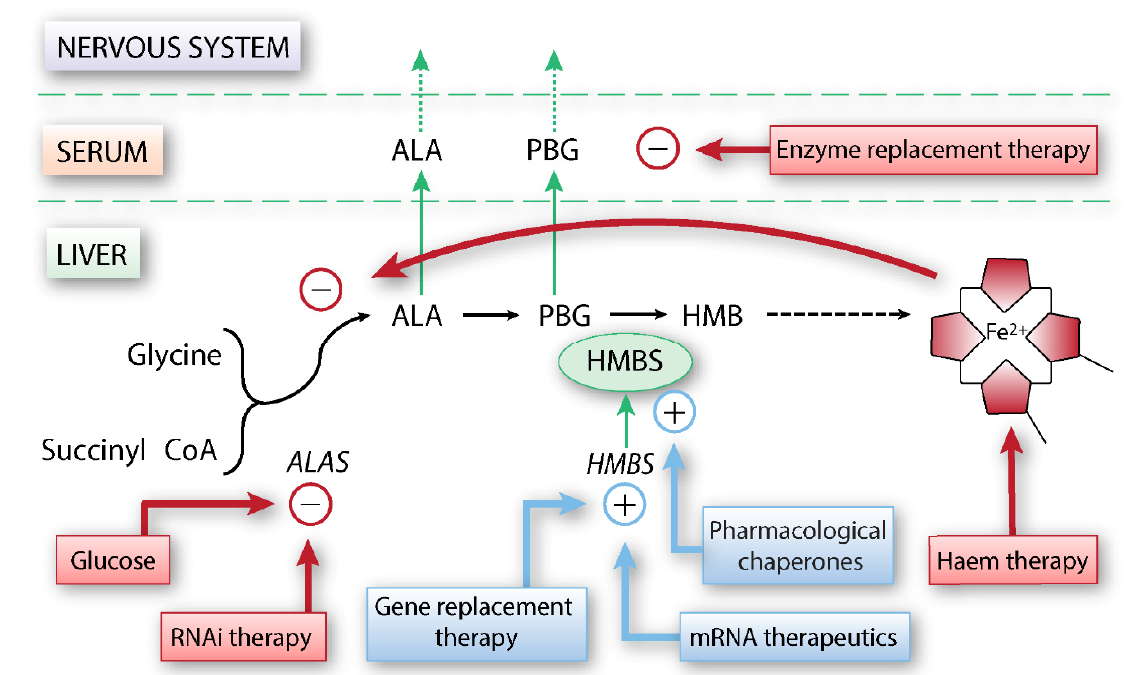
Figure 2. Overview of the action sites of established and potential therapy options for AIP. With a defect HMBS enzyme, ALA and PBG, produced in excess by the liver, leak into the bloodstream, and subsequently the nervous system. Therapeutic options that inhibit the pathway and/or accumulation of ALA and PBG are indicated in red, whereas options that enhance HMBS activity are shown in blue. Glucose treatment and RNAi therapy affect the ALAS1 gene expression, ultimately downregulating the haem biosynthesis. Haem infusions inhibit the haem biosynthesis by negative feedback on ALAS1. Gene replacement therapy and mRNA therapeutics aid in delivering normal HMBS capacity and pharmacological chaperones aid in the expression of the HMBS protein or help the already-expressed HMBS protein to function correctly. Enzyme replacement therapy aims to supply functional HMBS to deplete surplus amounts of ALA and PBG. Figure modified from [9] .